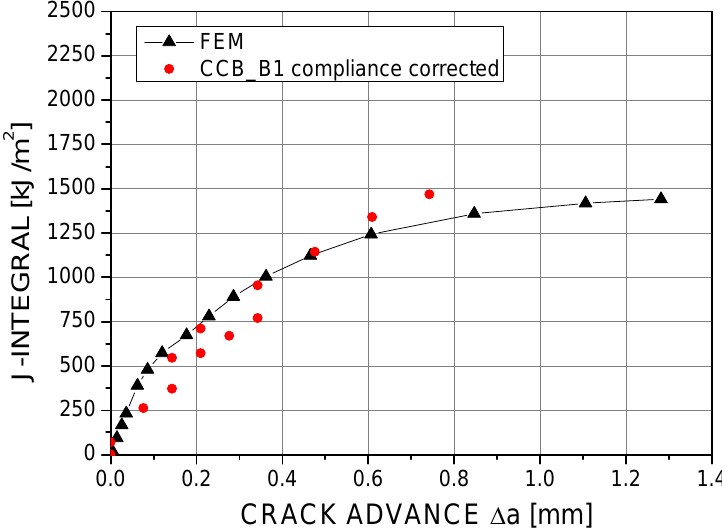
Figure 12: Crack resistance curve calculated considering the change in the unloading